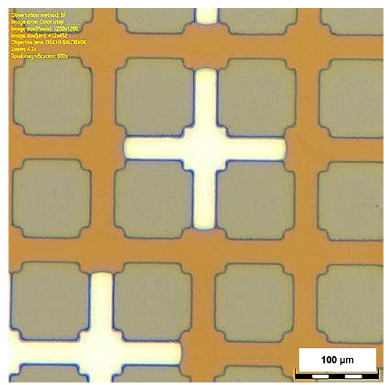
Figure 17. Microscope picture of GRID01. Wetting layers are not visible.